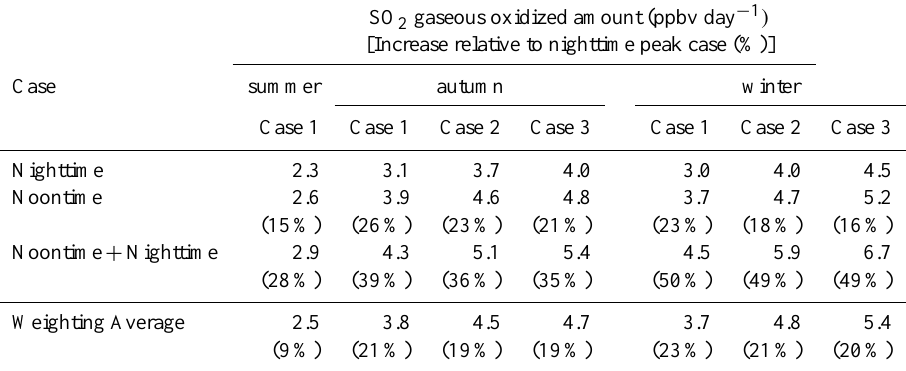
Table 4. Simulated SO 2 gaseous oxidation amount for the three different SO 2 diurnal variation patterns, the occurrence frequency (of the three groups) weighting averaged value, and the relative increase compared to the nighttime peak case. Case 1, case 2, and case 3 respectively represent cases using summertime VOC concentrations, doubled summertime VOC concentrations with half of the summertime isoprene concentrations, and tripled summertime VOC concentrations with a third of the summertime isoprene